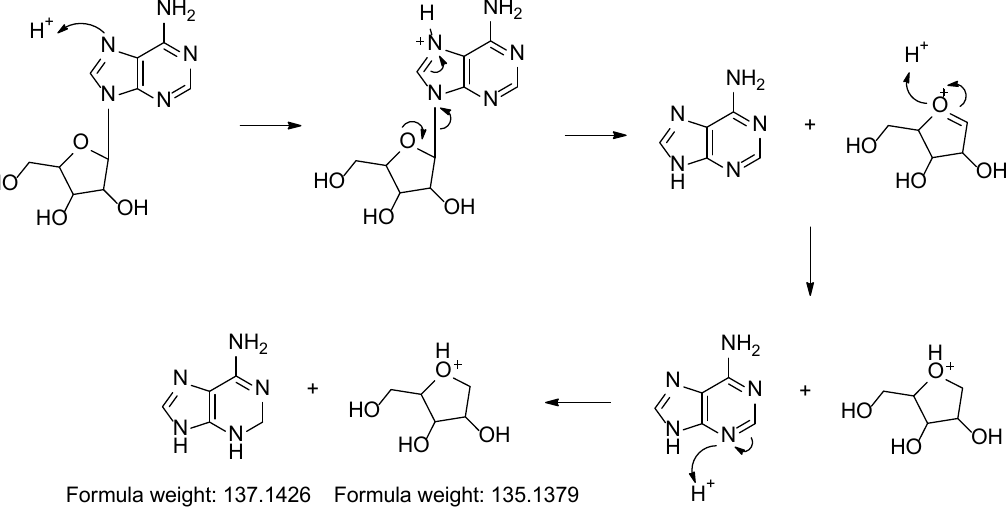
in the presence of [HCl] 1.0 M at 2